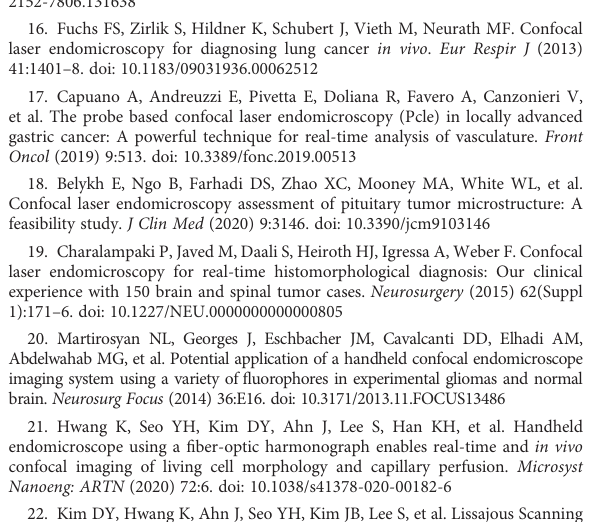
CLE scanned images from the same mouse were presented in Figure 3A.